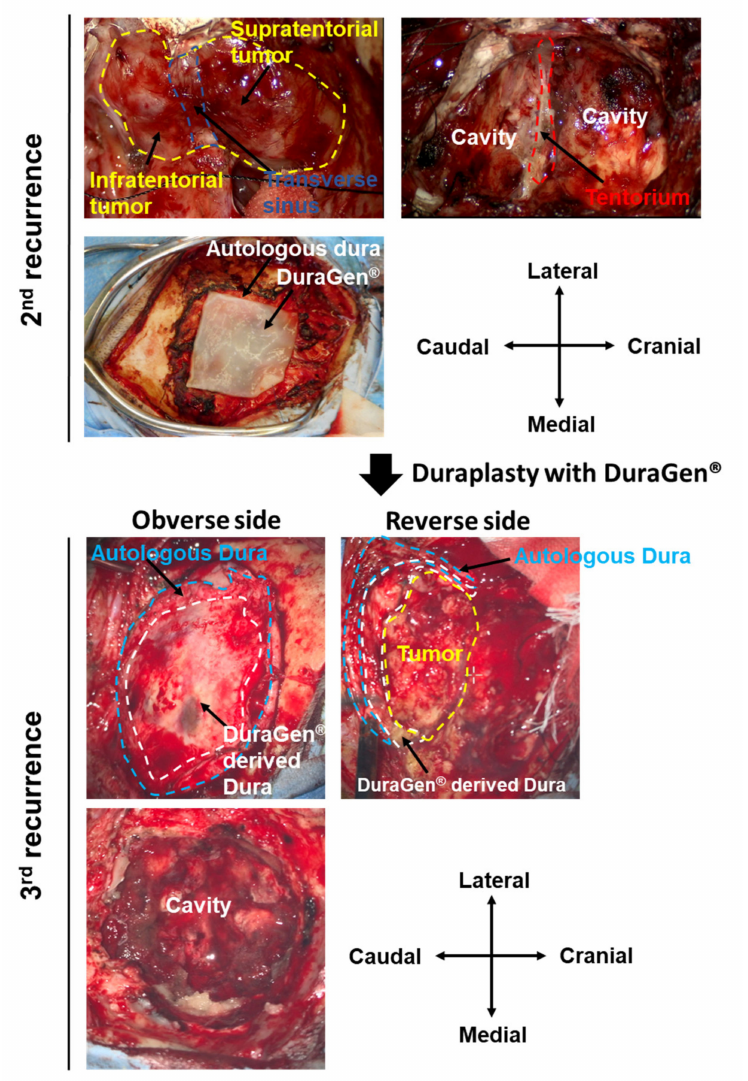
Figure 2. Intraoperative image. Simpson grade I resection (en bloc tumor and tentorium resection) could be achieved for the 2nd recurrent lesion. Transverse sinus occluded by the tumor invasion was completely removed. DuraGen ® was placed in order to achieve duraplasty. At the operation for the 3rd recurrence, the musculocutaneous flap was re-opened. Complete neoduralization of the DuraGen ® was observed above the tumor. Simpson grade I resection (en bloc tumor, and autologous dura mater and DuraGen ® -derived dura mater resection) was achieved again for the 3rd recurrent lesion. Upper panel : 2nd recurrence; lower panel : 3rd